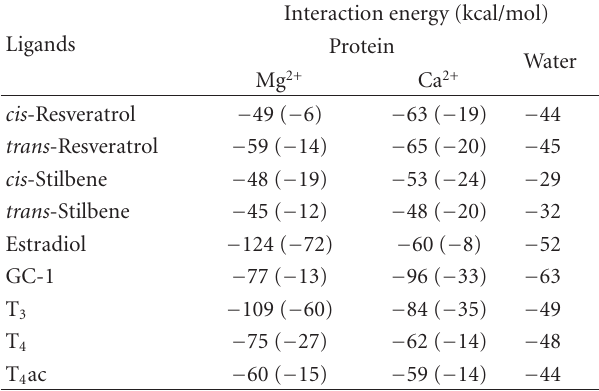
Table 1: The interaction energy between the ligands (Figure 2) and the protein (or water). Numbers in parenthesis indicate the interaction energy of the ligand bound in the protein relative to the interaction energy of this molecule in water. The interaction energy is calculated as a di ff erence between the energy of the ligand bound in the protein (or water) and the energy of this molecule in the gas phase, for the optimal geometry of this molecule bound in the protein (water) and the gas phase, respectively.